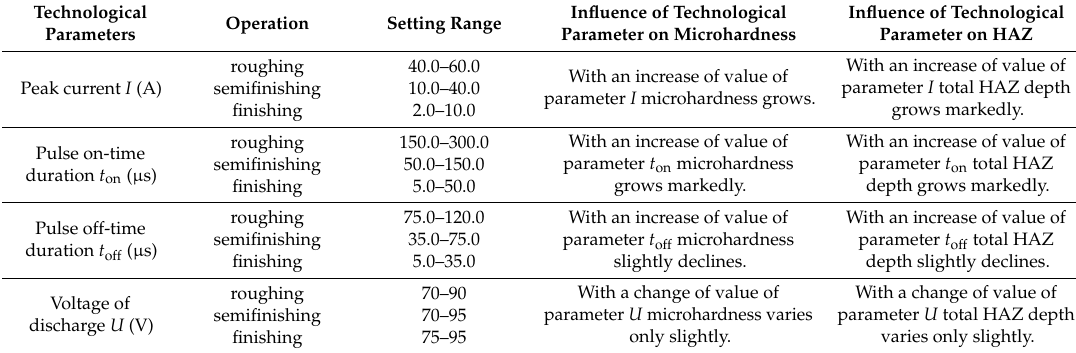
Table 1. Setting range of the main technological parameters for die-sinking electrical discharge machining (EDM), and their anticipated impact on the change of microhardness and the total depth of the heat affected zone (HAZ).